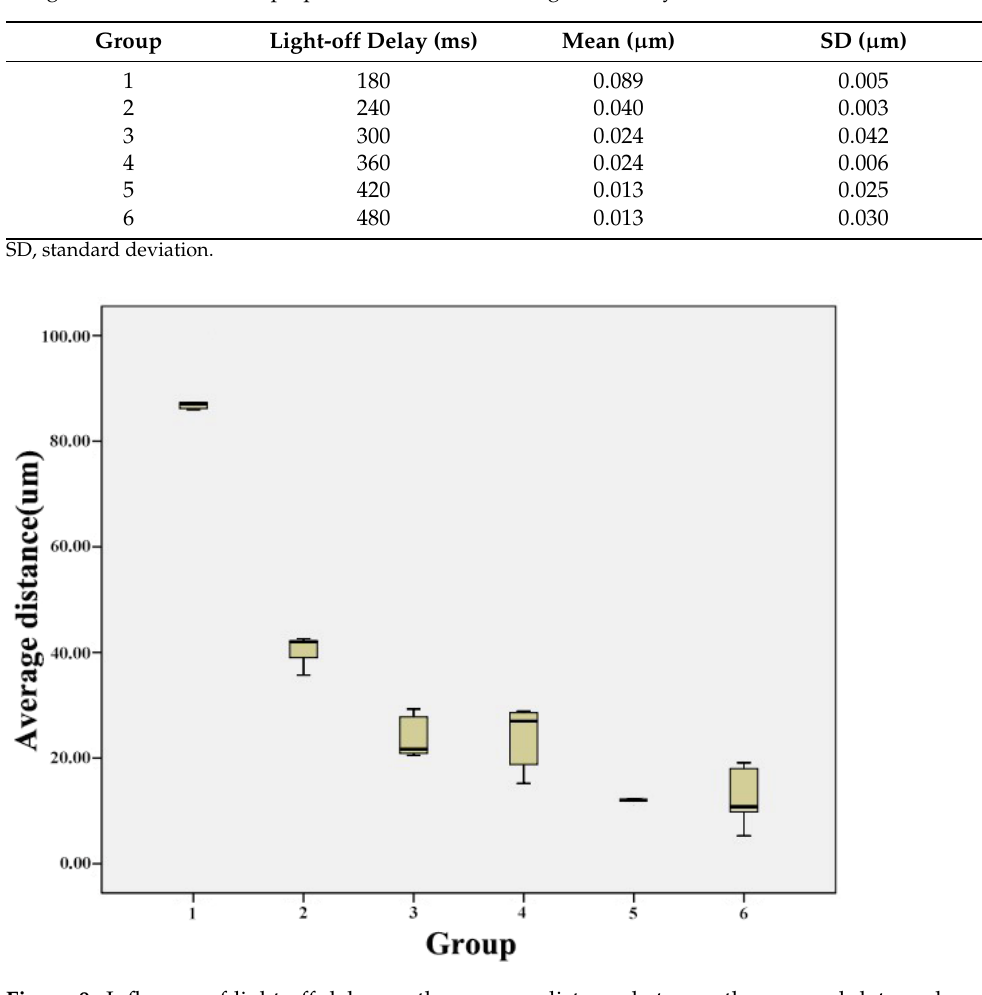
Table 3. Descriptive statistics of the average distance (in µ m) between the scanned data and pre- designed data of the tooth preparation with different light-off delays.